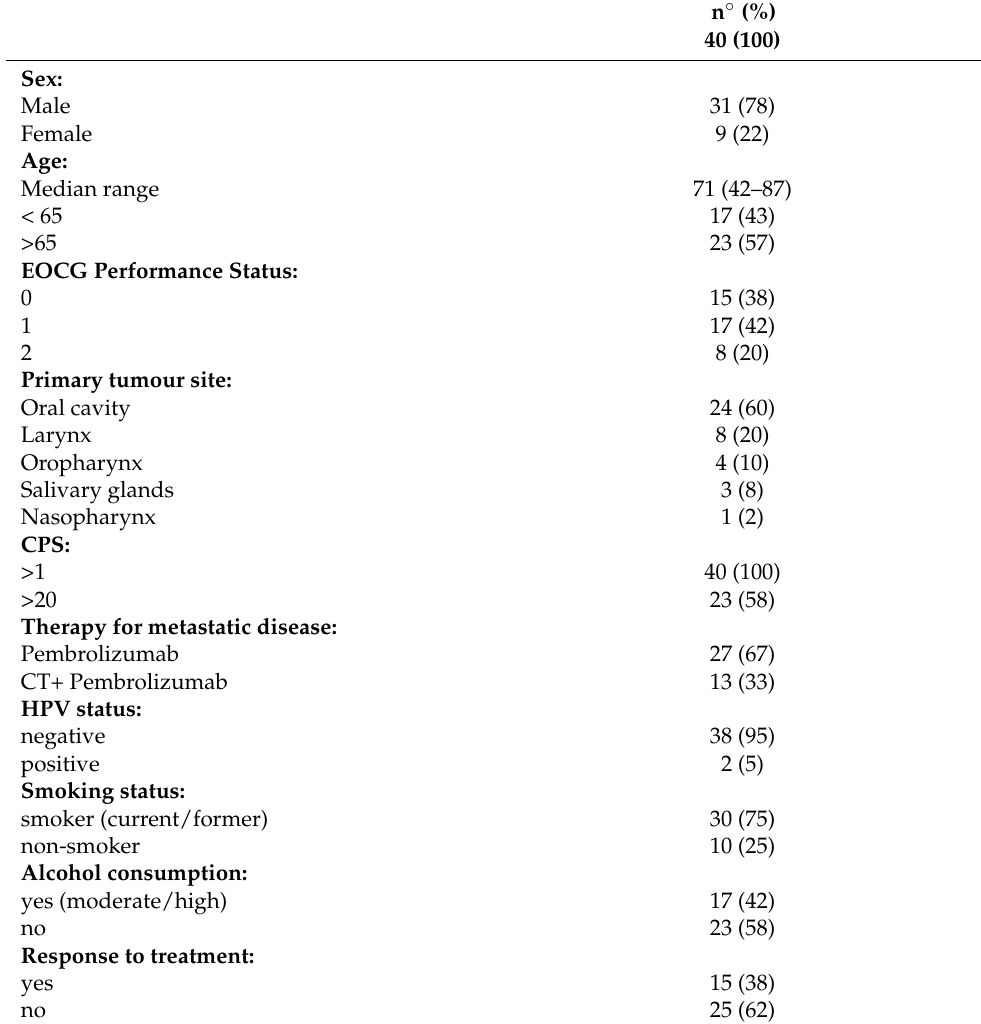
Table 1. Patients’